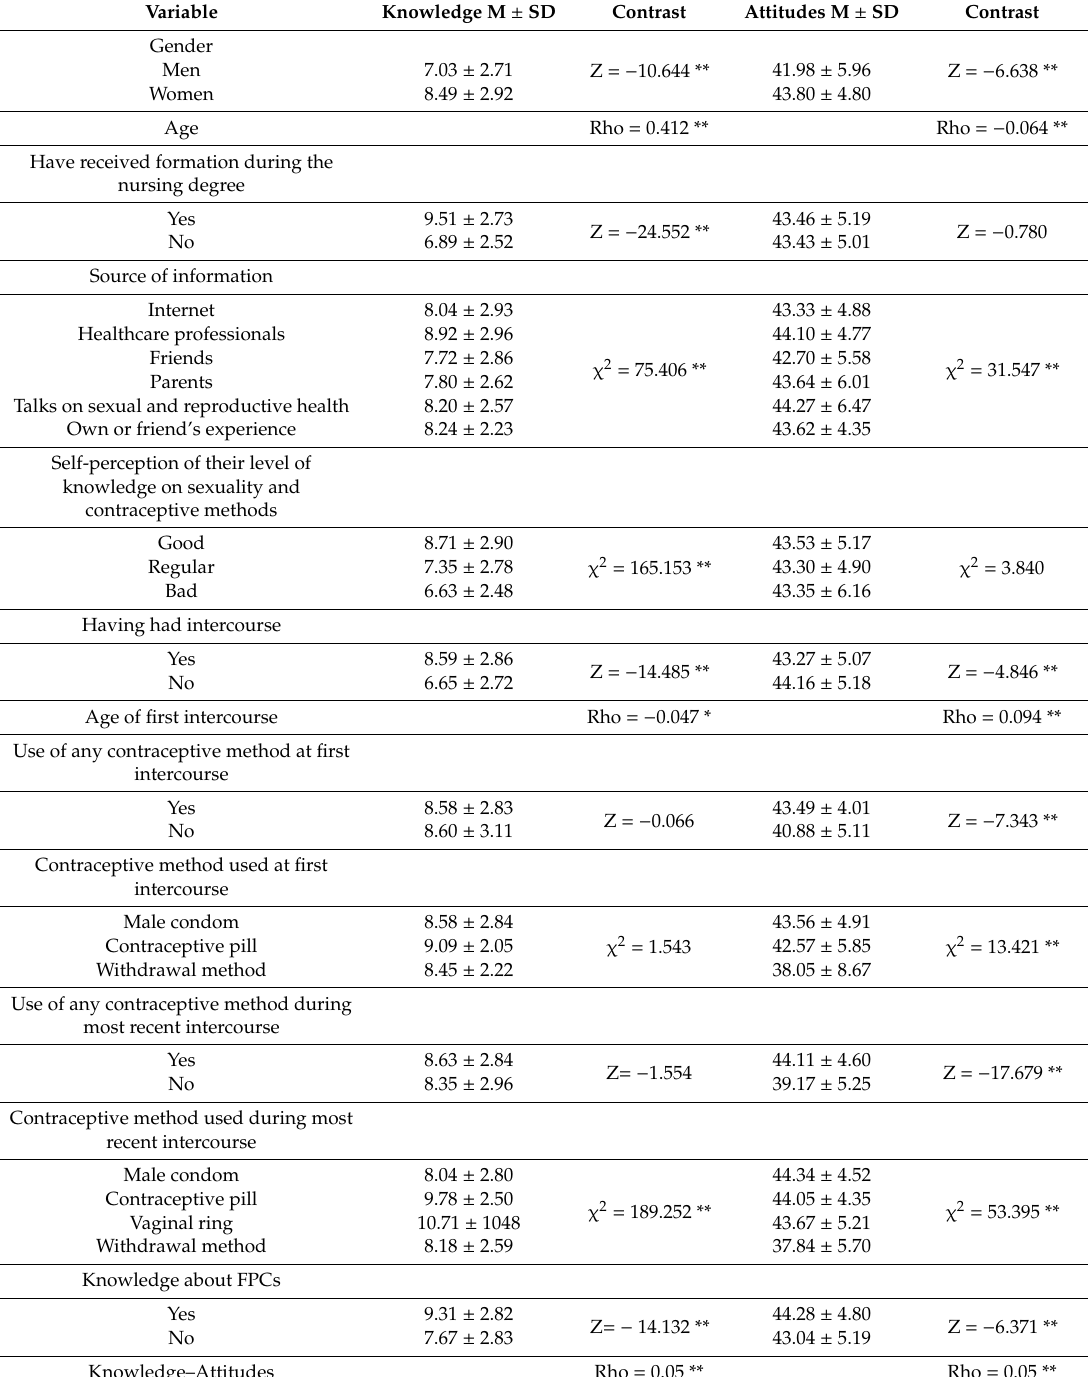
Table 4. Bivariate contrasts for the SexContraKnow-Instrument scale and the Attitude toward Contraceptive use